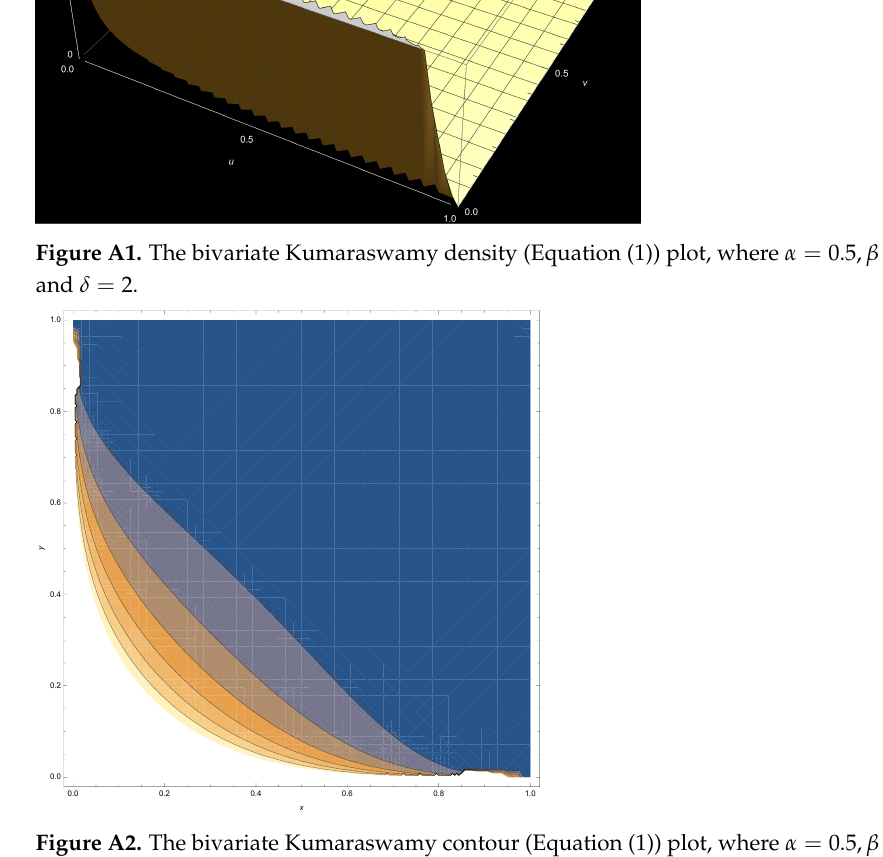
Figure A2. The bivariate Kumaraswamy contour (Equation (1)) plot, where α = 0.5, β = 0.5, θ = 0.5 and δ = 2.